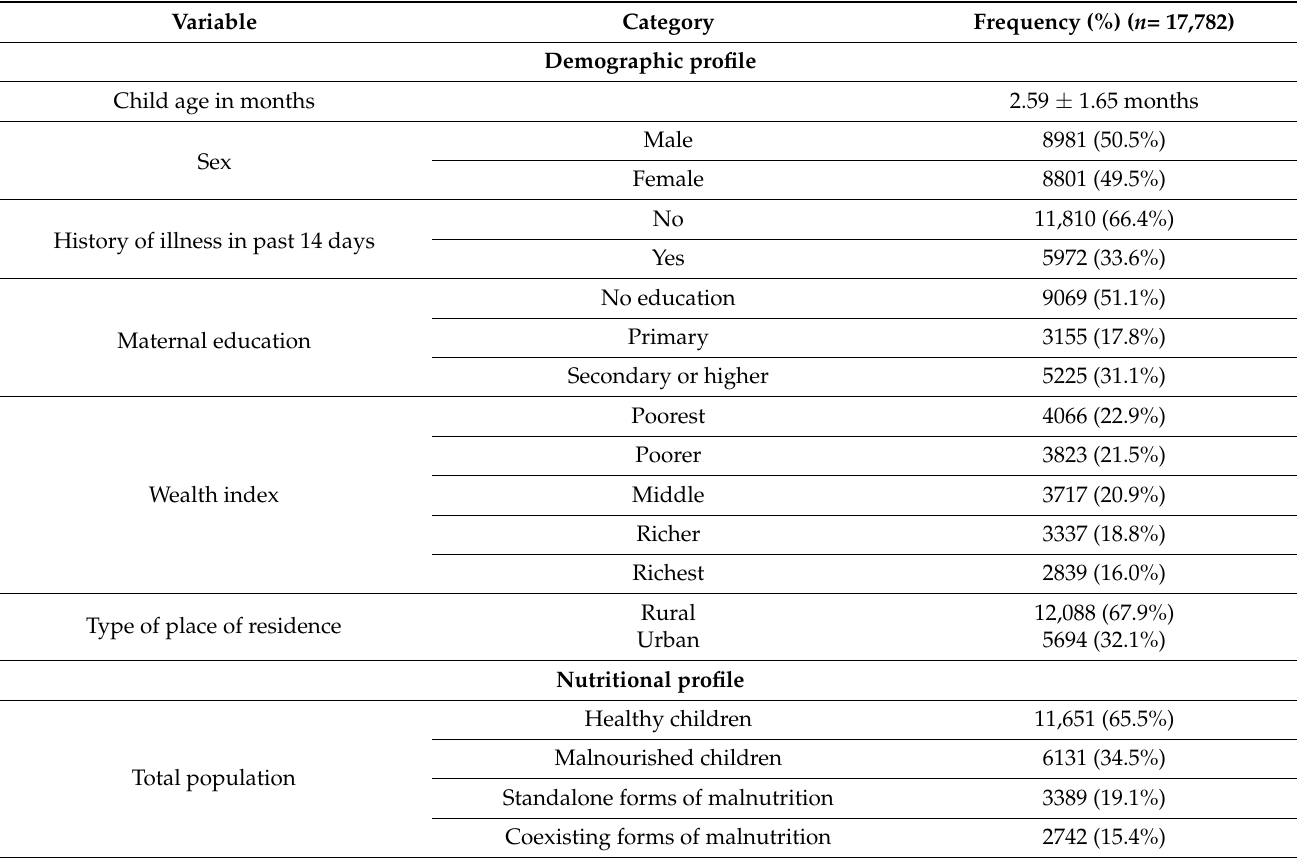
Table 1. Demographic, health, and feeding profile of children aged 0 to 5.9